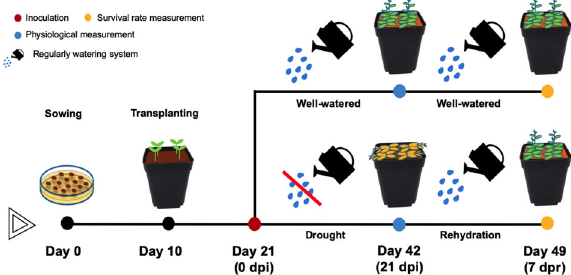
Fig. 6 The timeline for plant experiments under drought and well-watered conditions. At day 21 (0 dpi), three-week-old Arabidopsis plants were inoculated with different bacterial suspen- sion including SPMX, dead SPMX and each individual strain of SPMX. After that, for well-watered treatment, inoculated plants were watered regularly every three days (500 ml of distilled water per tray each time, 20 pots were put in each tray). Inoculated plants were treated with drought by withholding watering for 21 days. At day 42 (21 dpi), regularly watering was resumed for the inoculated plants exposed to 21-day drought. To evaluate drought tolerance, survival rate of each treatment was measured after 7 days post re-watering (7